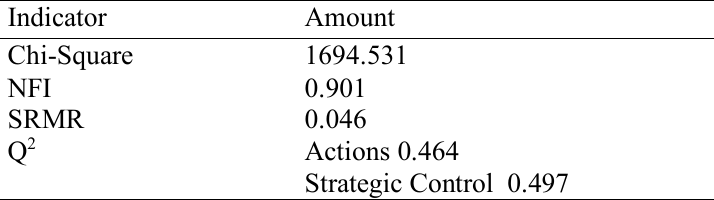
Table5. Chi-Square, NFI, SRMR, and Q 2